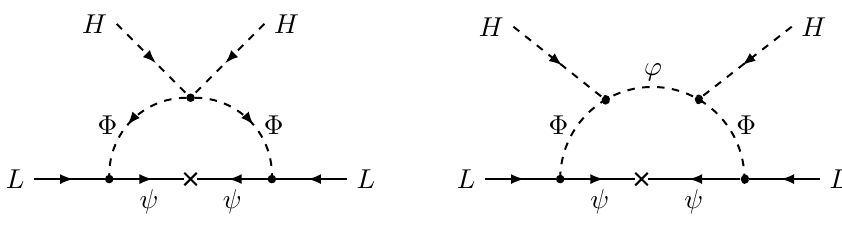
Figure 1 . Feynman diagrams for the neutrino masses at the one-loop level. The left panel shows the contribution in the Scotogenic Model (proportional to λ the new contribution in the ScotoSinglet Model (ScSM) (proportional to κ 2